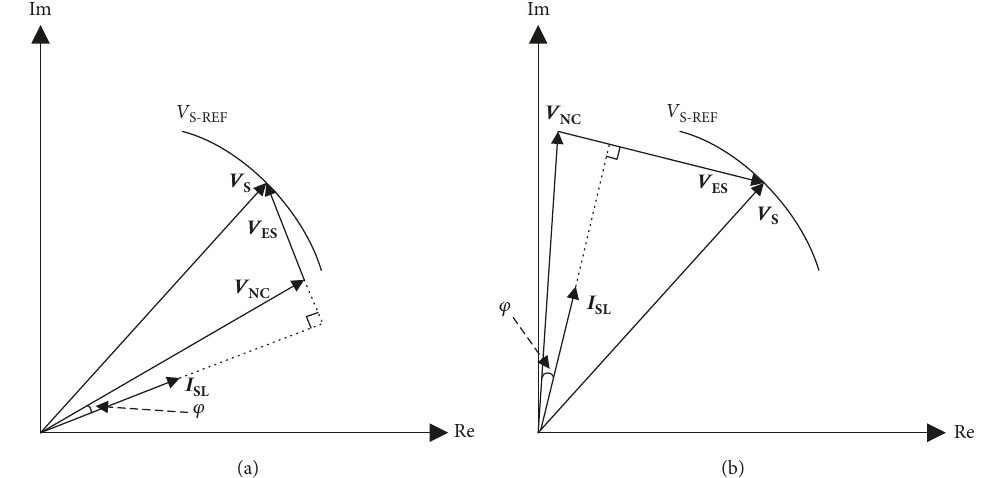
Figure 2: The vector diagram when ES is applied to restrain the bus voltage fluctuation caused by DG. (a) Inductive mode. (b) Capacitive mode.